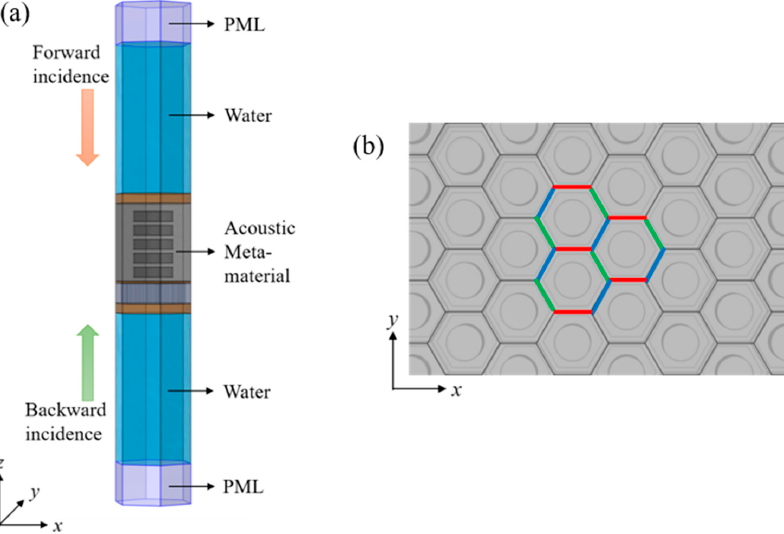
Figure 2. ( a ) Schematic diagram of the employed three-dimensional (3D) coordinate system, forward and backward incidence. ( b ) Depiction of the 3D spatial arrangement with periodic boundary conditions.